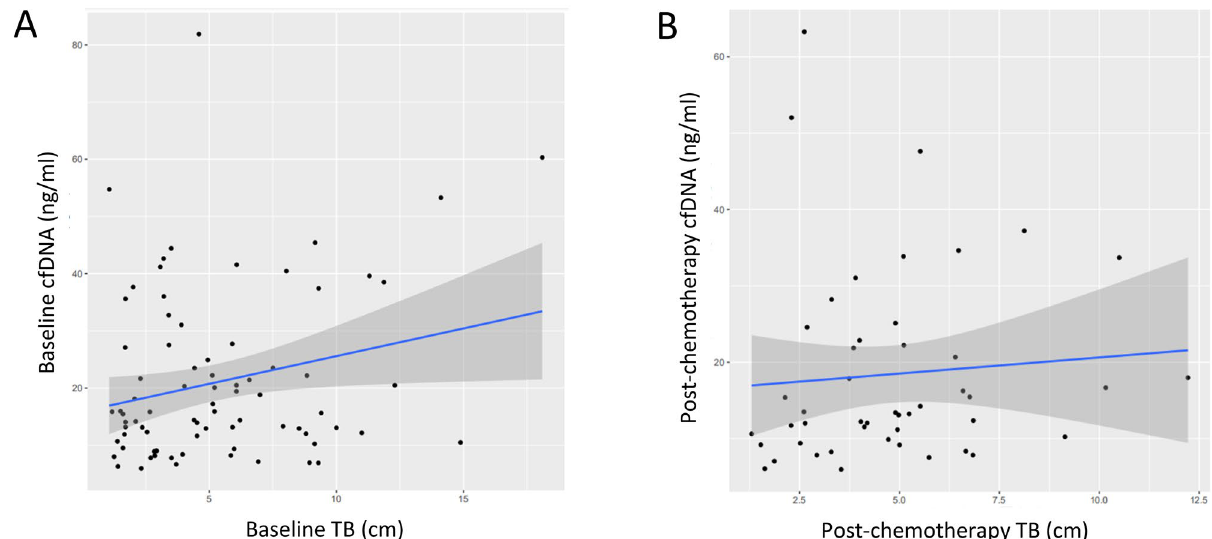
Figure 1. Scatter plot showing a weakly positive correlation of baseline cfDNA with baseline tumor burden. Tumor burden was evaluated by response evaluation criteria in solid tumors, version 1.1. cfDNA was quantified by QuantiDNA Direct cfDNA Test Kit (Diacarta. Inc., CA, USA) according to the manual both ( A ) at baseline and ( B ) post-chemotherapy. We selected those whose interval between cfDNA test and TB evaluation was within 7 days, so 80 cases were qualified ( A ) at baseline, and 47 cases were qualified ( B ) post-chemotherapy. A weakly positive correlation between TB and cfDNA was observed at baseline ( N = 80, Pearson’s coefficient =